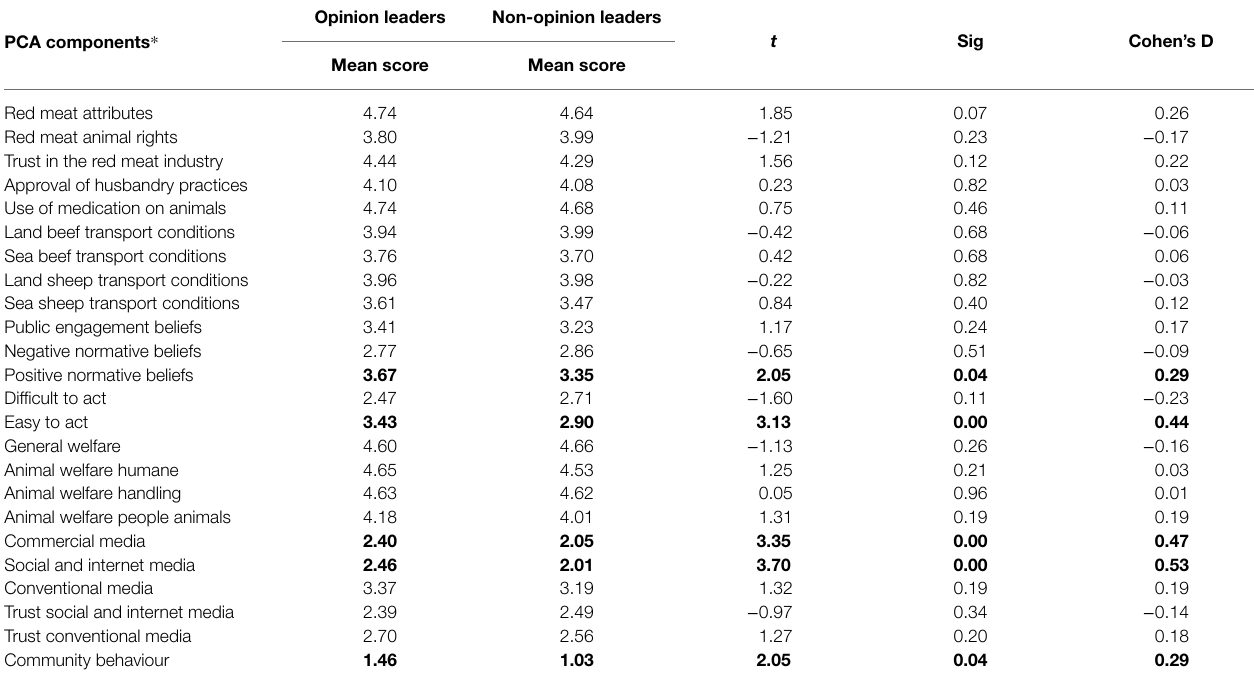
* Label definitions – see Table 1 for details. Values highlighted in the table are statistically significant.